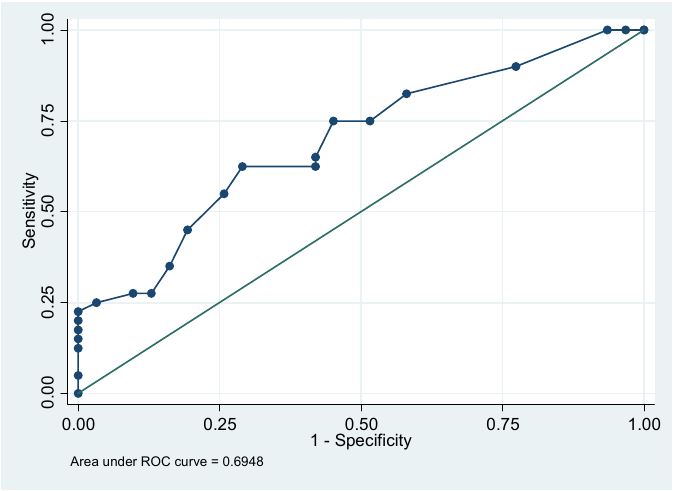
Figure 6. Receiver operating characteristics (ROC) curve (sensitivity vs. 1—specificity) for condylar hyperplasia activity detection by mandibular deviation.